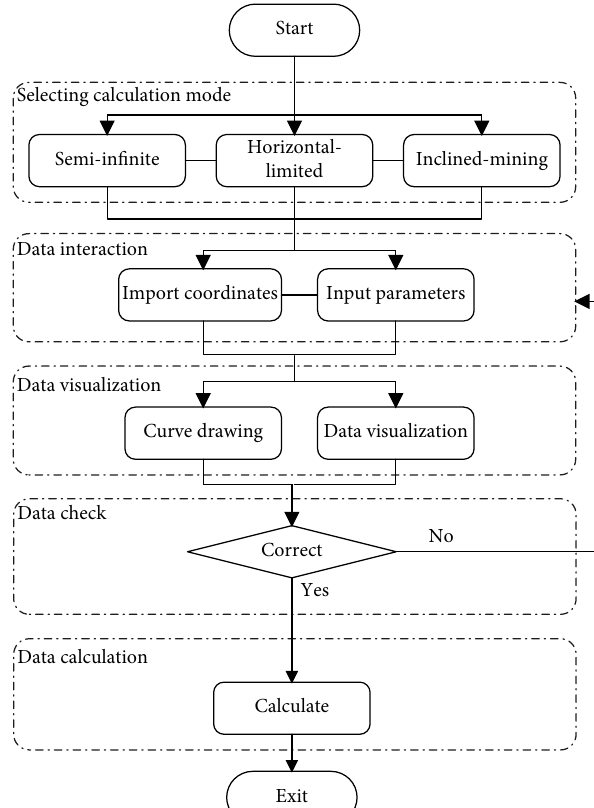
Figure 7: Model calculation fl ow chart.